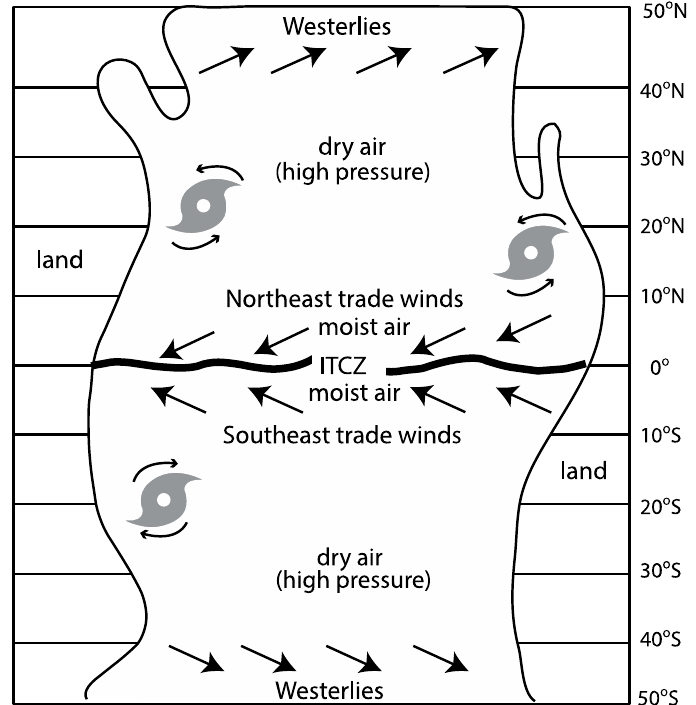
Figure 2. Cartoon model for present-day ocean-current circulation stimulated by the Westerlies and Trade winds with icons representing tropical cyclones (hurricanes/typhoons) that rotate counter- clockwise in the northern hemisphere and clockwise in the southern hemisphere (ITCZ = Inter Trop- ical Convergence Zone). Marginal seas are figurative, but shown as coastal embayments character- istic of Mexico’s Gulf of California and China’s Yellow Sea.